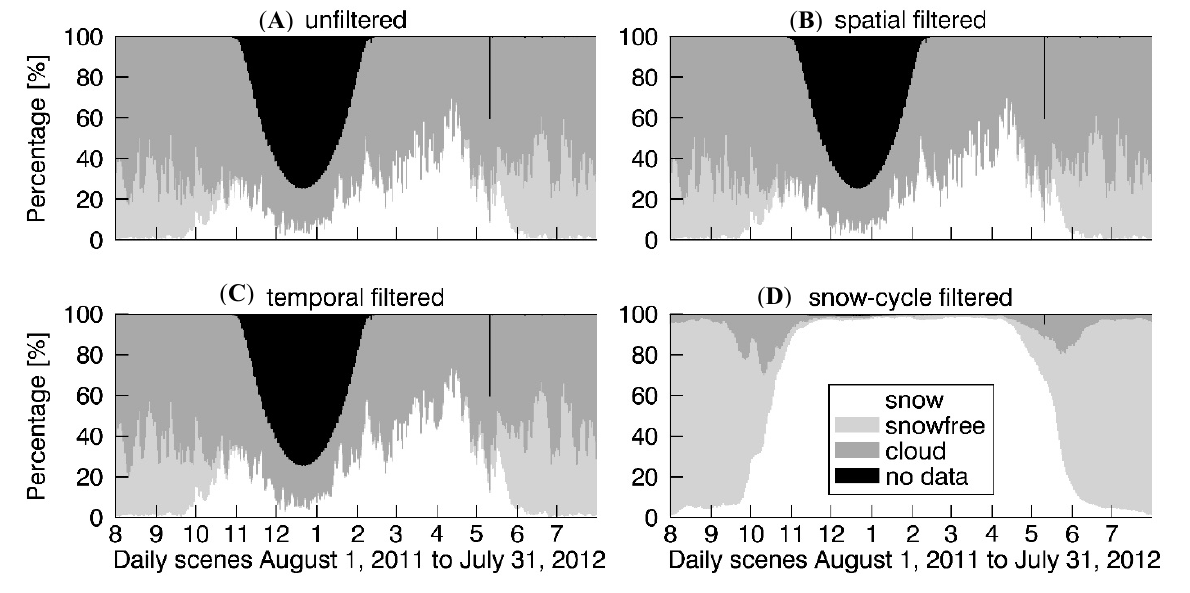
Figure 2. Stepwise results from the spatial, temporal, and snow cycle cloud removal process for 2012 snow year. Filtering was applied to snow, snow free, cloud, and non-valid pixels ( A ) for unfiltered scenes; ( B ) after spatial filtering; ( C ) after temporal filtering; and ( D ) after snow-cycle filtering. Note missing data on May 11, 2012 from data outage due to spacecraft